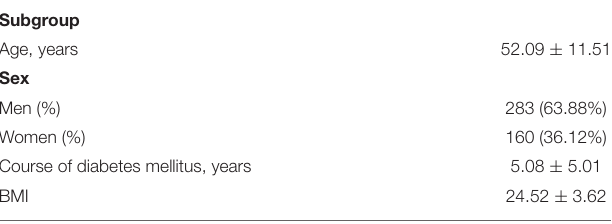
TABLE 1 | Demographic characteristics of the